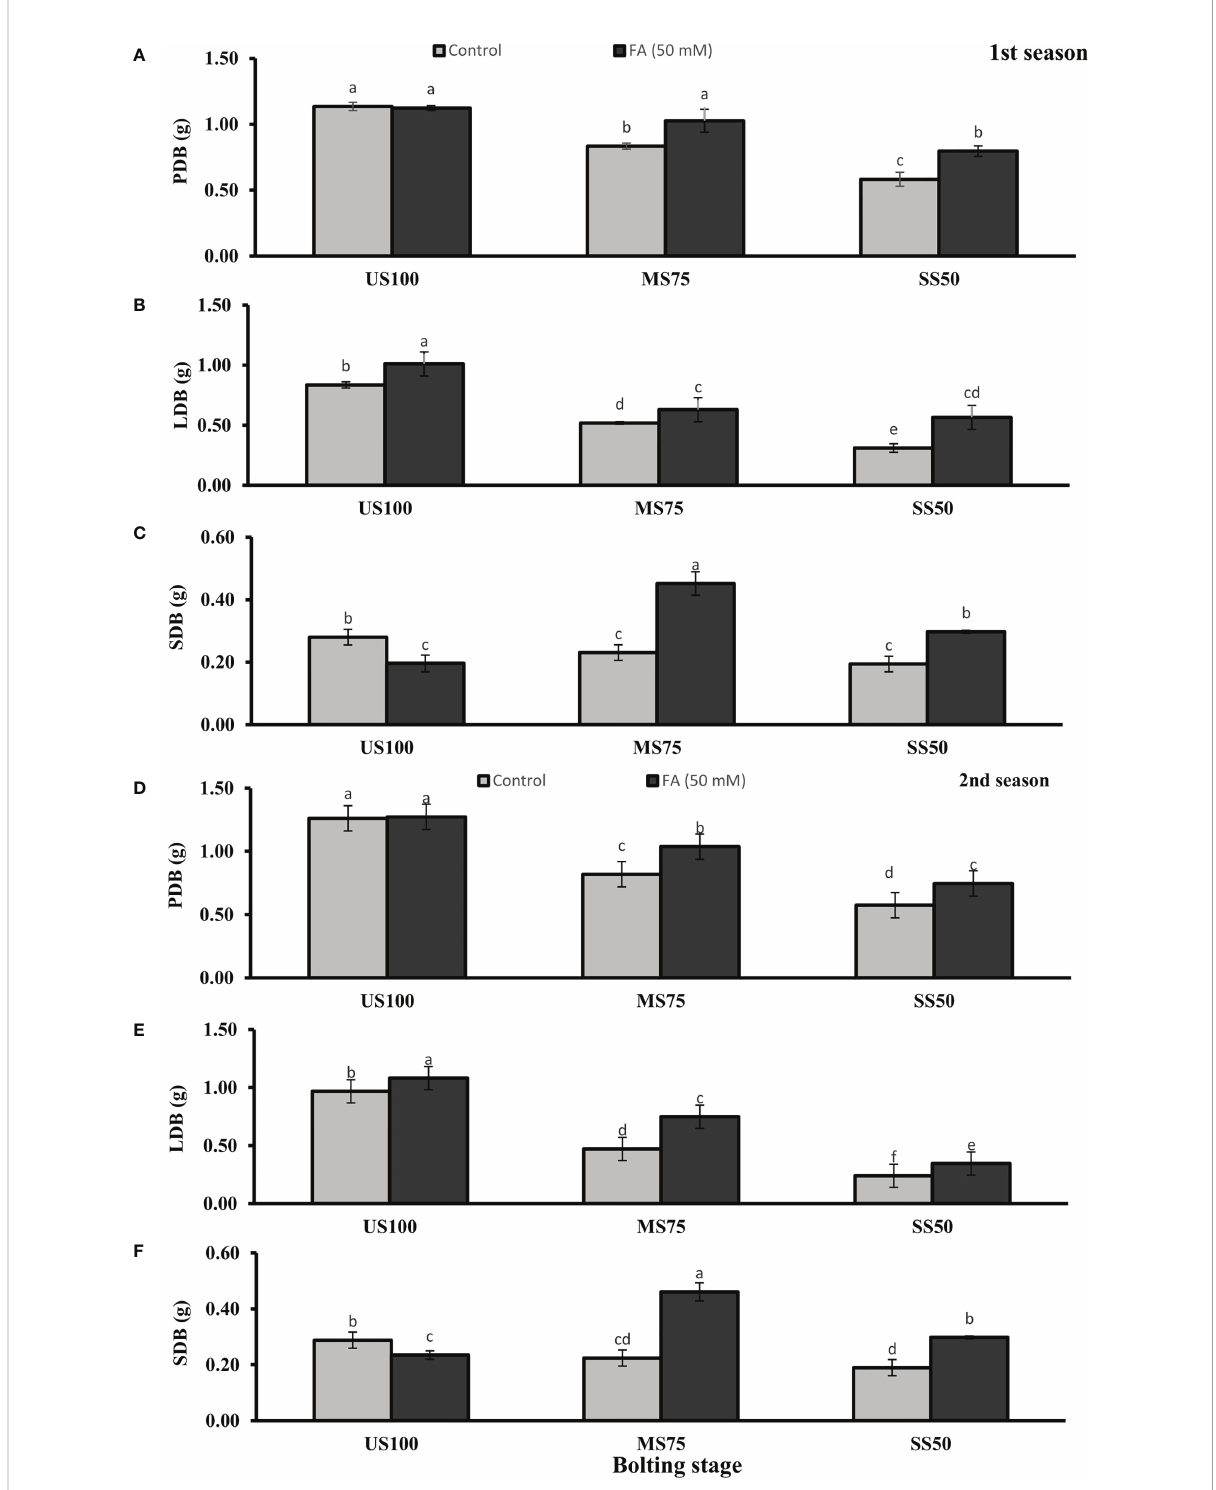
FIGURE 4 Effect of foliar application of folic acid (50 mM) at bolting stage on (A, D) plant fresh biomass/plant, (B, E) leaf fresh biomass/plant, (C, F) and shoot fresh biomass in the fi rst and second seasons. The graph values are the mean ± SE of four replicates. The bars exhibited with different letters indicate a signi fi cant difference between samples by least signi fi cant difference ( p ≤